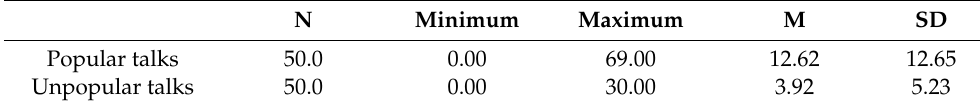
Table 1. Summary of statistics for the humor frequency of TED Talks.